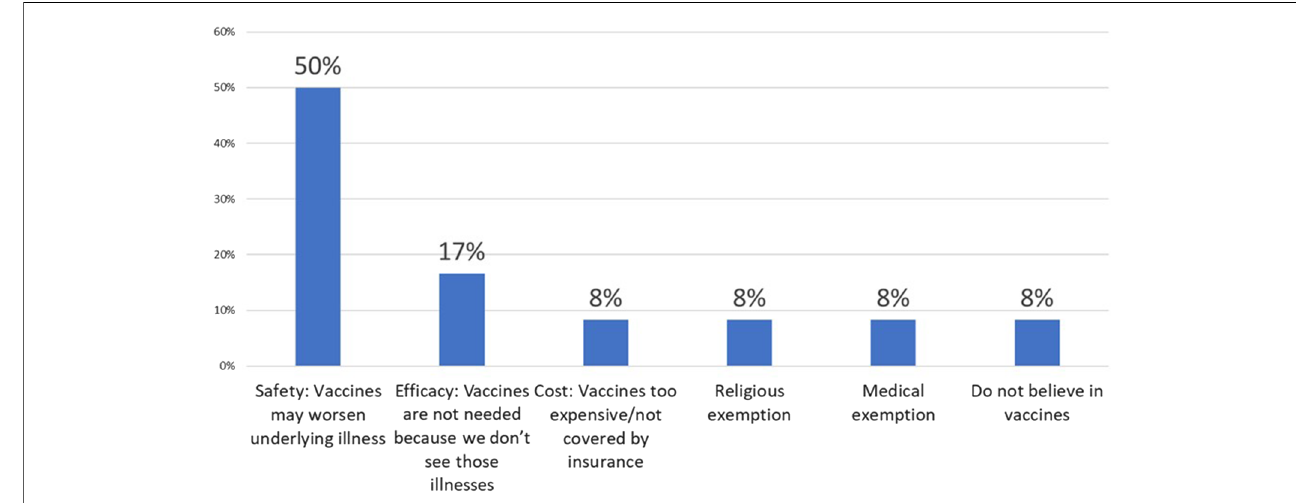
FIGURE 3 Reasons for vaccine refusal in ICC per PCP. Other: 1% “ Anti-vaxer philosophy ”